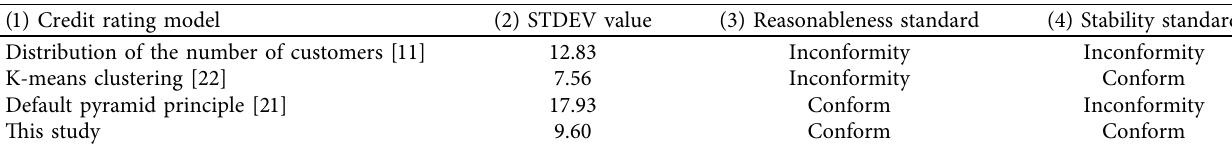
Table 8: STDEV stability indicators for different